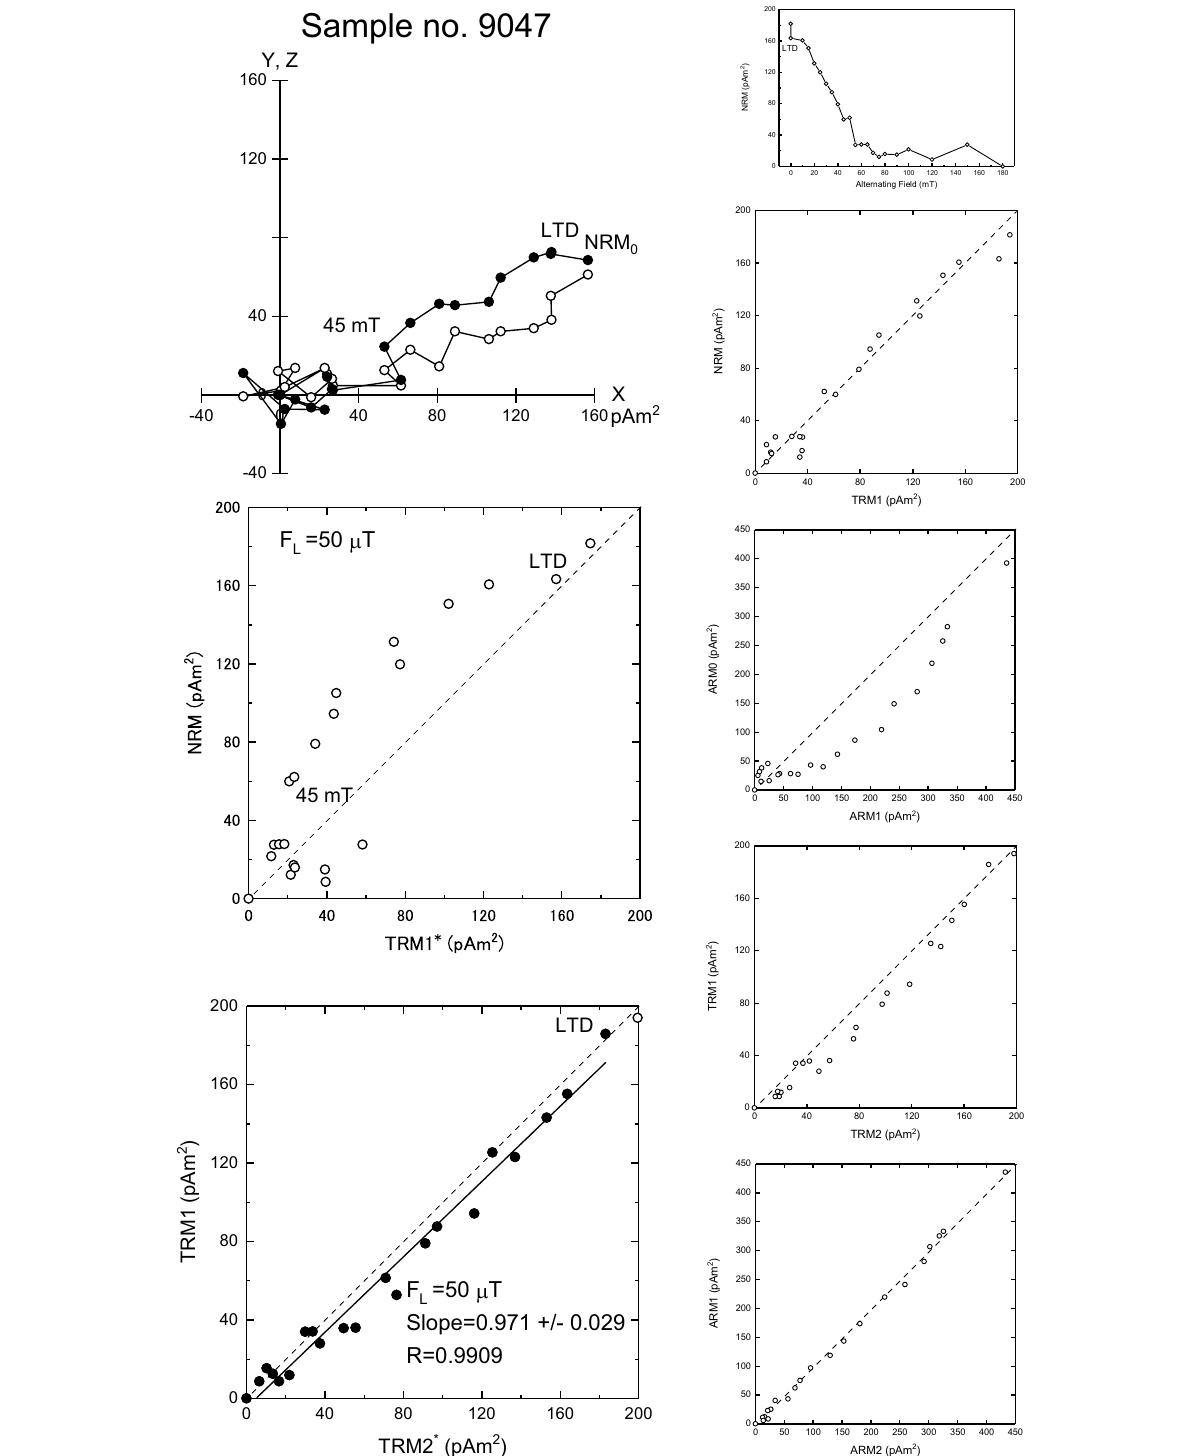
Fig. 10 Example of failed paleointensity measurements by the Tsunakawa–Shaw method on single plagioclase grain. In the orthogonal plot, open and closed circles indicate X – Y and X – Z planes, respectively. No linear portion in the NRM/TRM1*